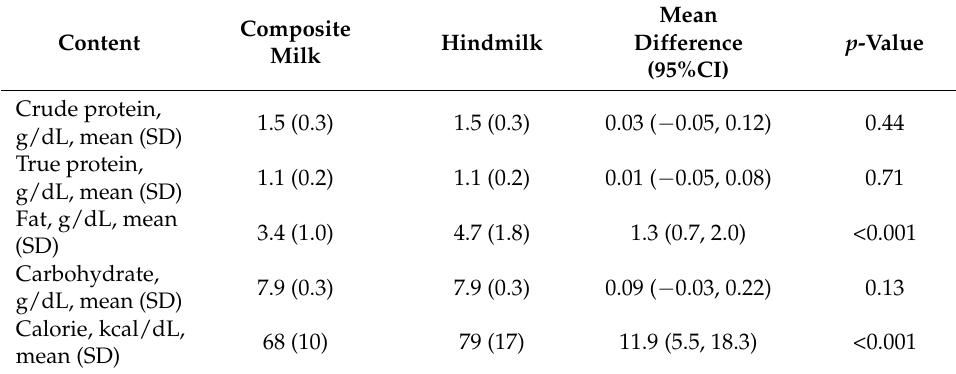
Figure 2. ( A ) Daily total fluid, energy, and protein intakes during the study period. ( B ) Z − scores at the start of hindmilk and after 4 weeks. * p − value < 0.05, ** p − value < 0.01, dash bars are standard error of the mean. Table 2. Macronutrient content of composite milk and hindmilk.